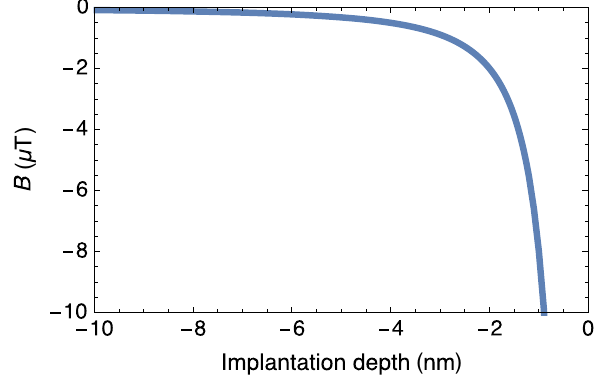
FIG. 6. Calculated magnetic field at the site of a muon at a distance of minus the implantation depth above the surface of Cr 2 O 3